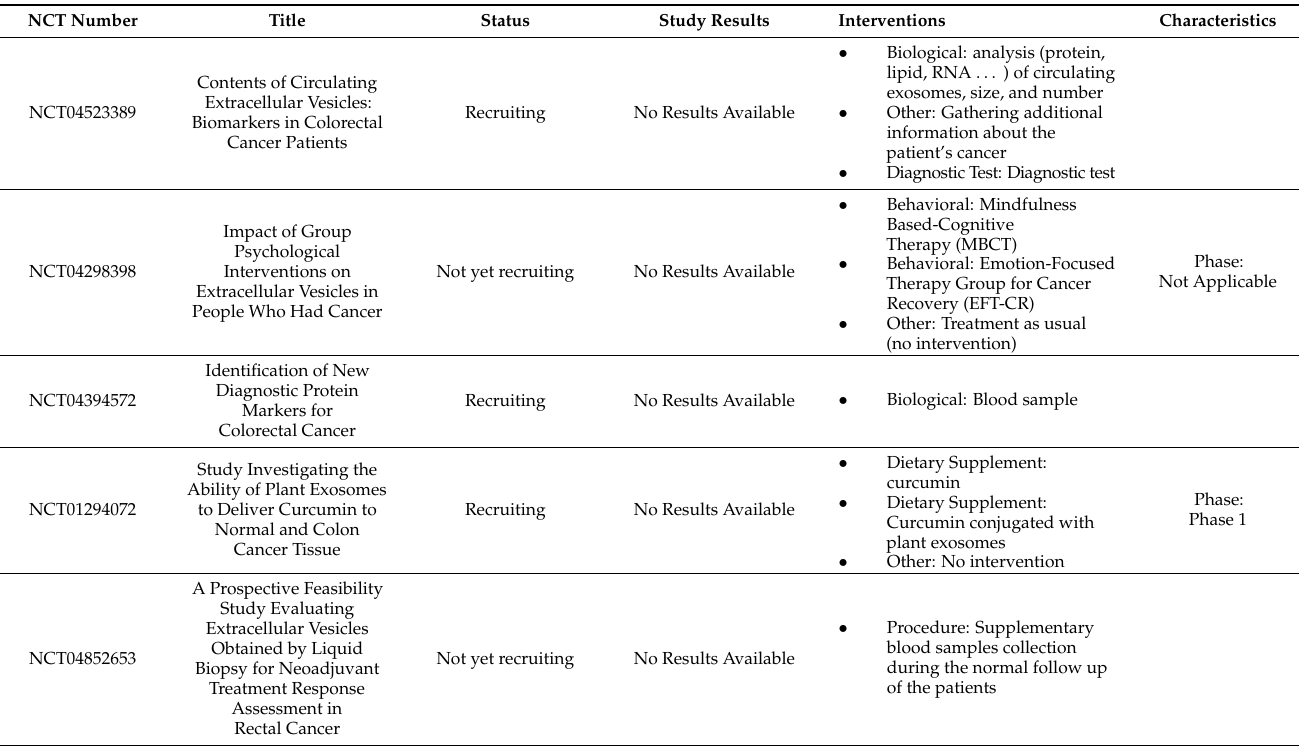
Table 2. Clinical trials related to the use of sEVs for the diagnosis and treatment of